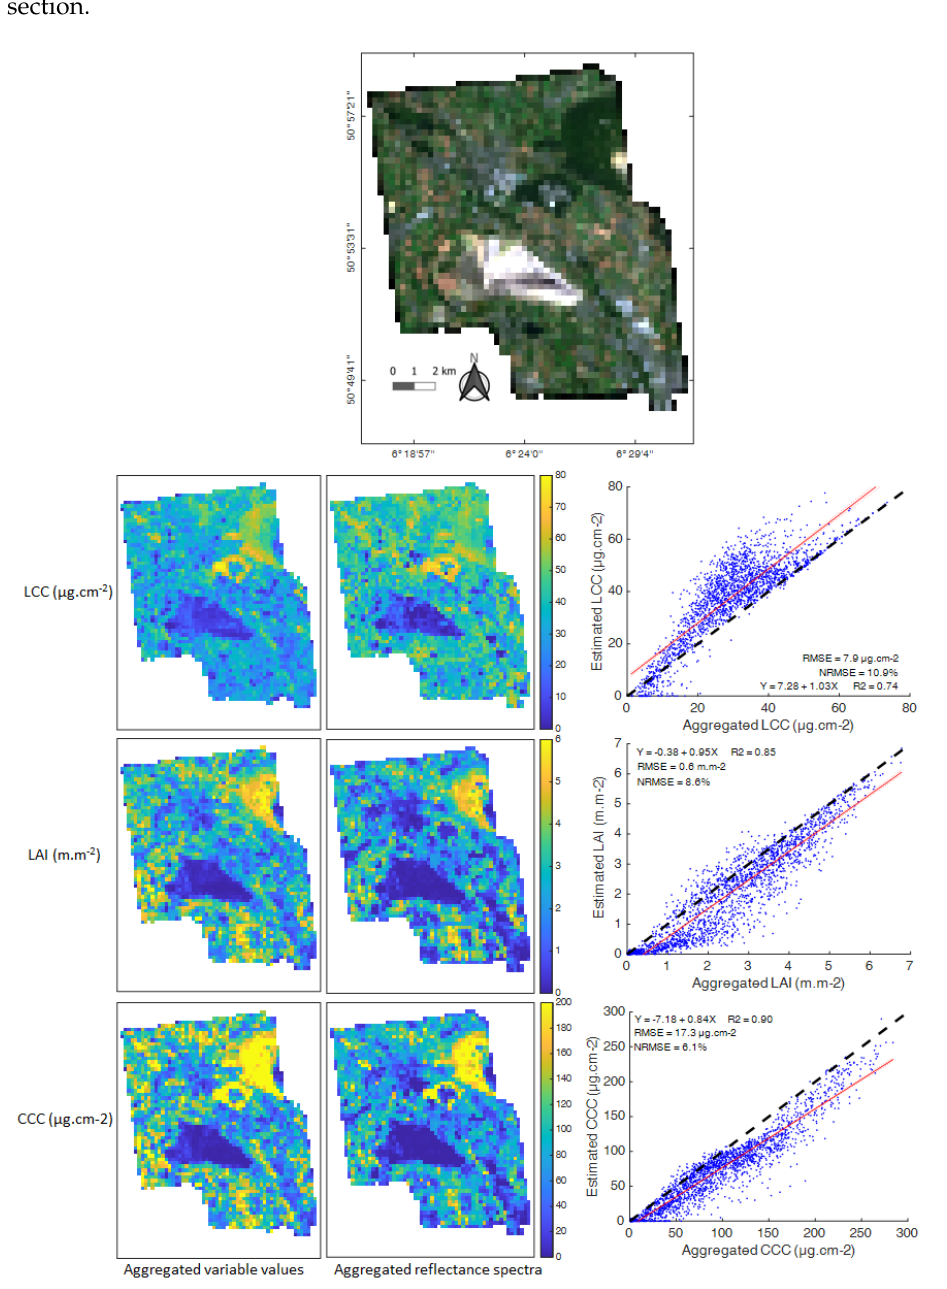
Figure 9. Comparison between estimated values derived from the application of the retrieval models to Hyplant* observations at a moderate scale (300 m) and at a fine scale (3 m). First column: Fine-scale estimations from the 3 m Hyplant* data were aggregated to 300 m; middle column: Moderate-scale estimations from the 300 m aggregated Hyplant* data; right column: Scatterplots between retrieval maps from the two first columns. The RGB (665; 560; 490 nm) image is the entire Hyplant image rescaled at a 300 m spatial